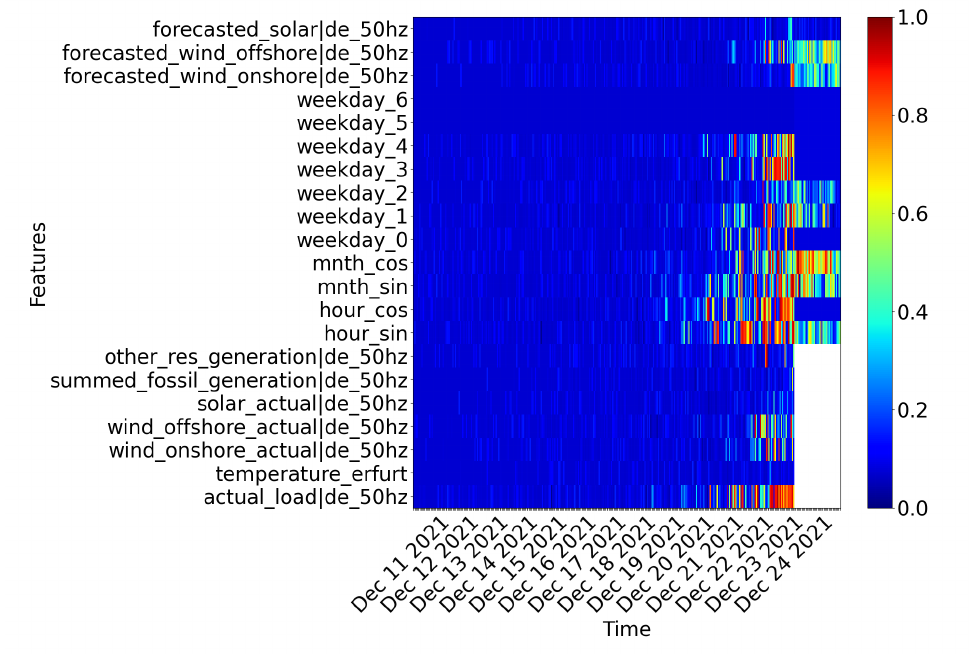
Figure 11. Saliency map of the feature importance for the prediction on 24 December